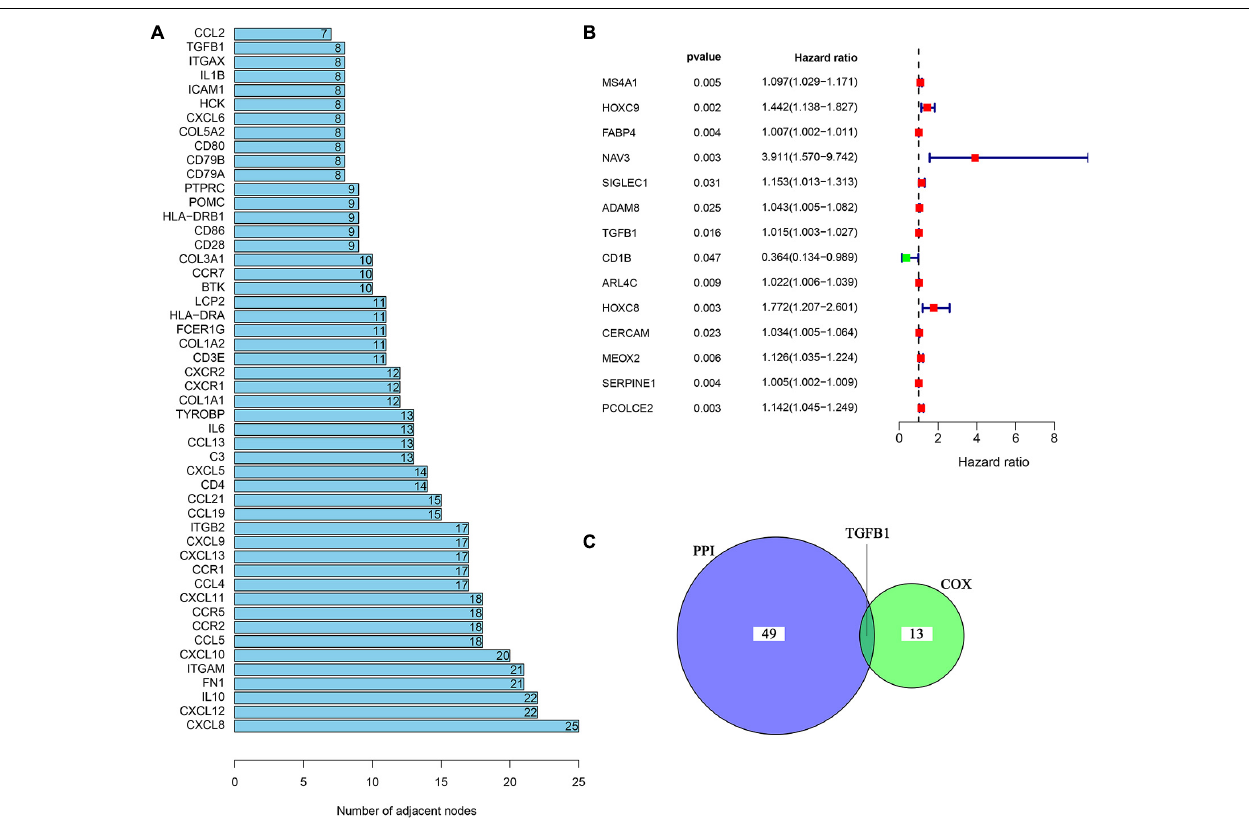
FIGURE 5 | Univariate COX regression analysis of DEGs. (A) The top 50 genes ranked by the number of nodes. (B) Univariate COX regression analysis of DEGs. p < 0.05 was considered as the significance threshold. (C) Venn plot displays the common genes shared by the top 50 genes in PPI and top significant genes in univariate COX regression